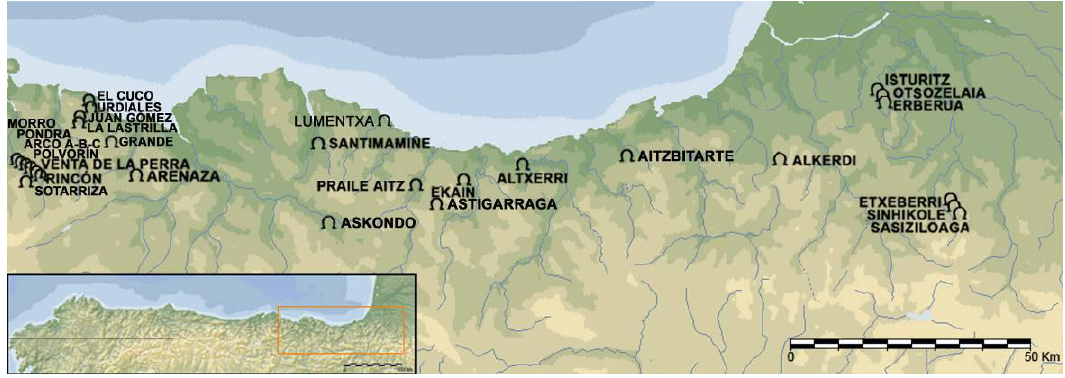
Figure 1. Location of the Isturitz cave among the decorated caves of the Bay of